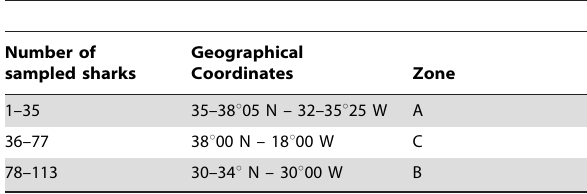
Table 1. Geographical coordinates of sampled individuals of shortfin mako